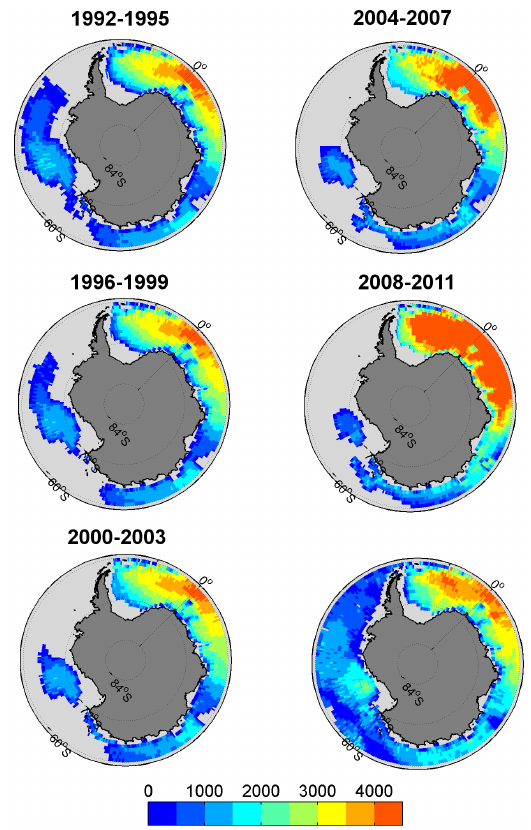
Figure 18. Four-year averages of the AABW layer thickness (m) based on the ECCO2 data for the period 1992–2010. The bottom- right panel shows the 20-year average AABW layer thickness based on observational